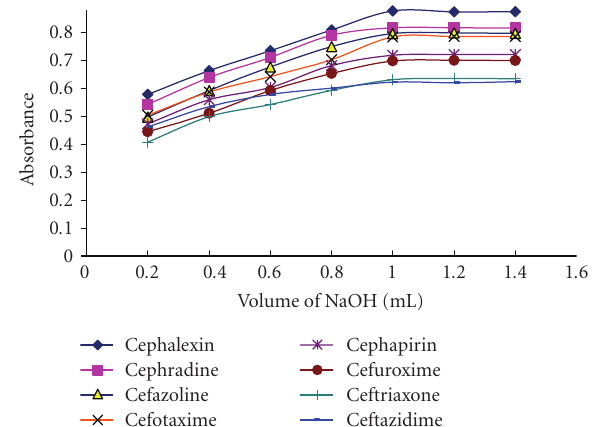
Figure 1: Absorption spectra of (a) alkaline potassium perman- ganate (6 × 10 − 3 M) (b) cefotaxime (15 μ g mL − 1 ) and (c) the reaction product.